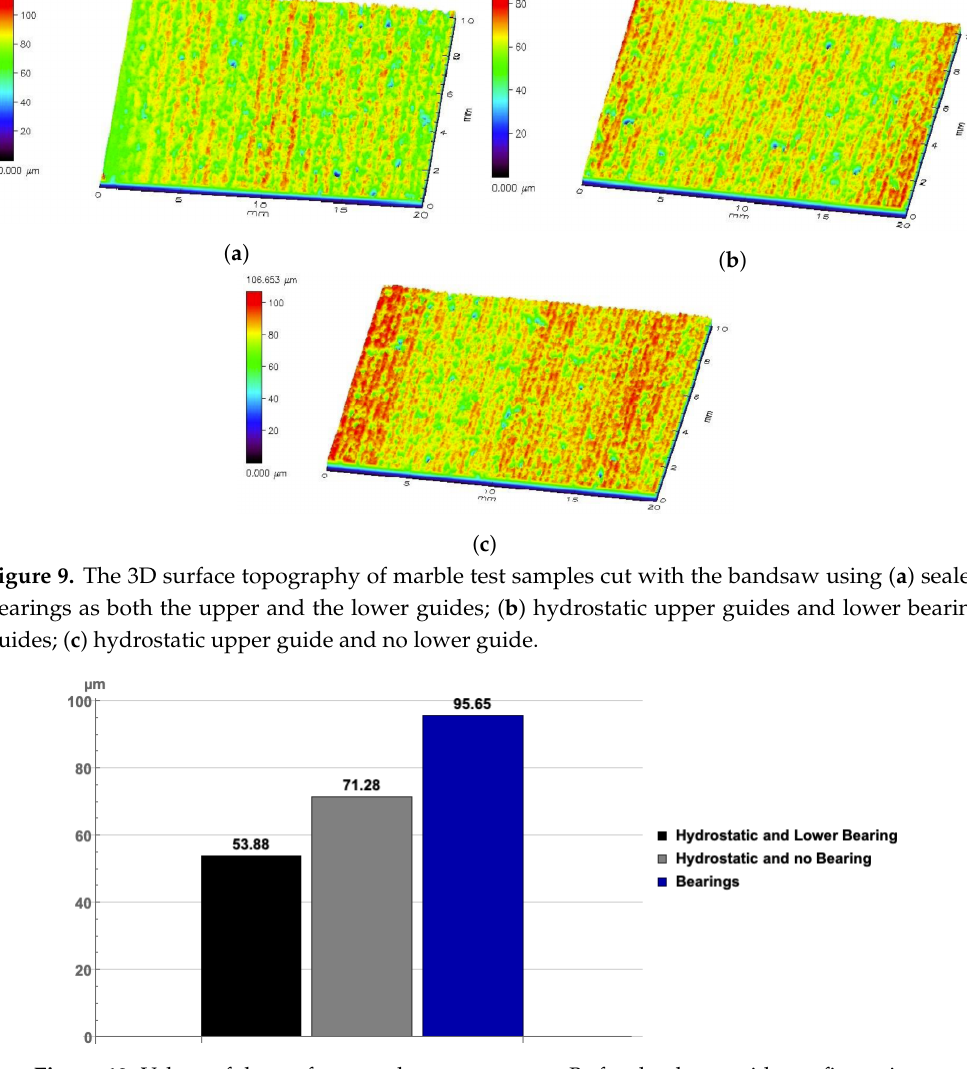
Figure 10. Values of the surface roughness parameter R z for the three guide